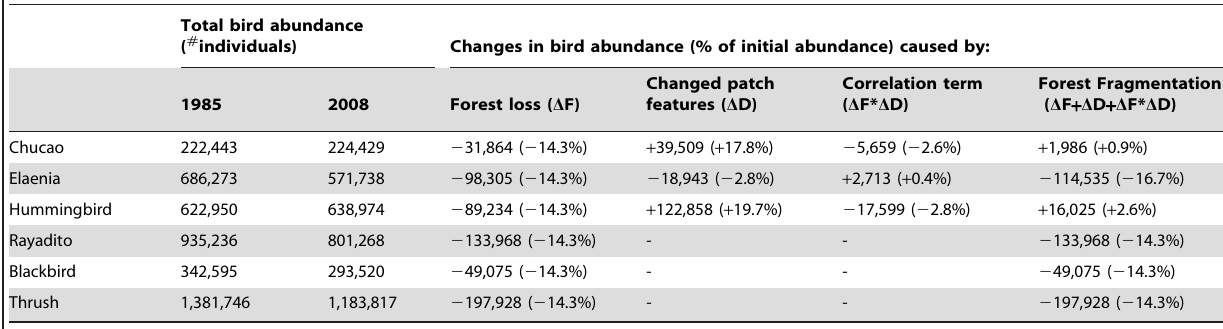
Table 5. Total bird abundance in the study area for six forest-bird species, due to (the various components of) forest